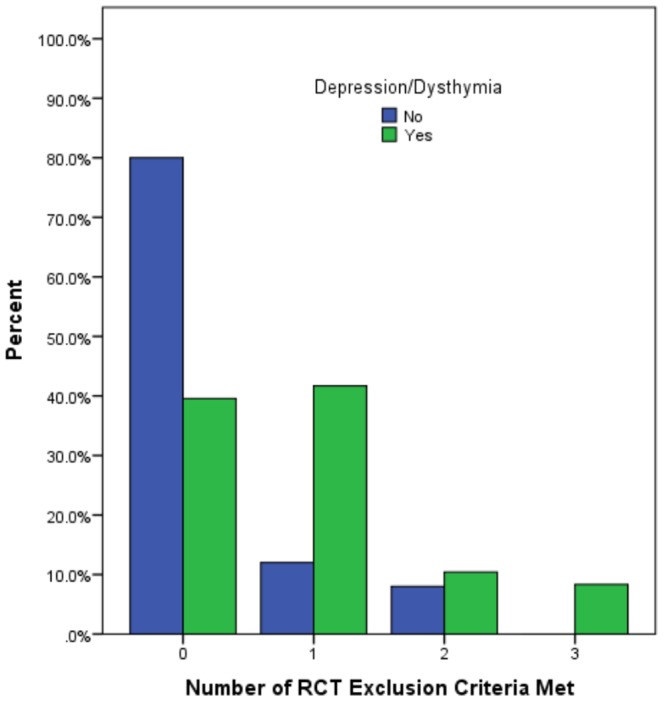
Proportion of standard RCT exclusion criteria met by HF patients according to depression status (yes vs. no).